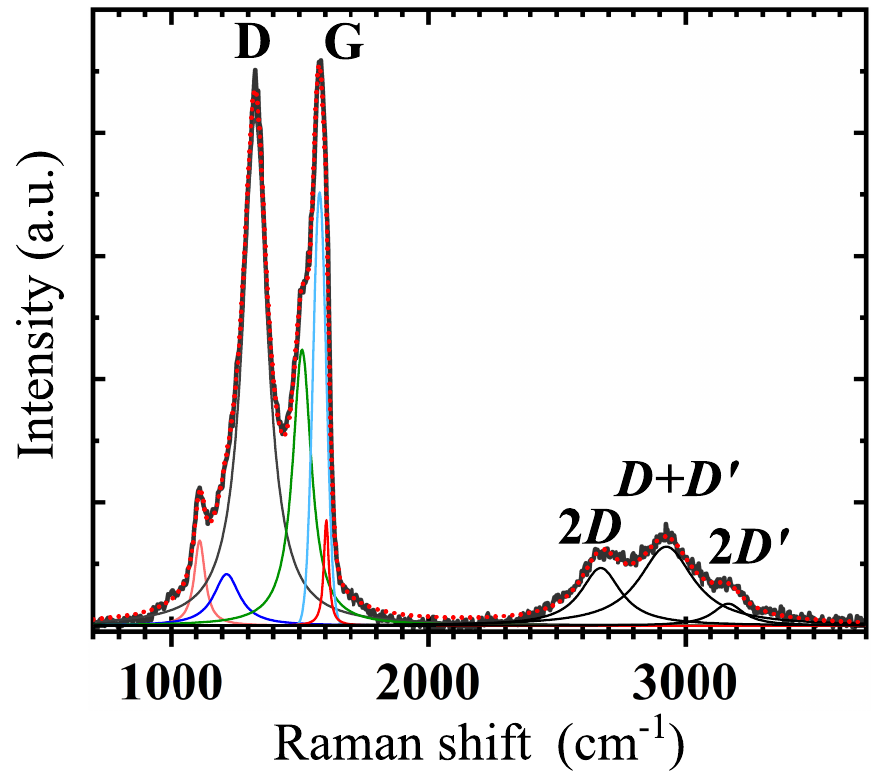
Figure 5. Raman spectrum of the GS at 293 K. The measured spectrum (thick and dark grey solid line) has been deconvoluted by Lorenzian and Voigt ( G -peak only) functions into peaks and bands (coloured thin lines). Corresponding data are quoted in Table 2. The cumulative fitting curve is reproduced as red